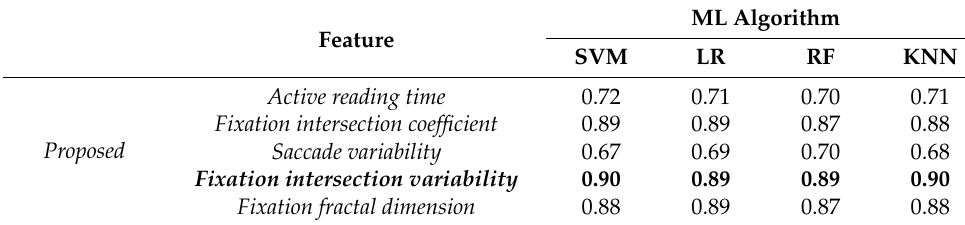
Table A3. F1 score for single feature